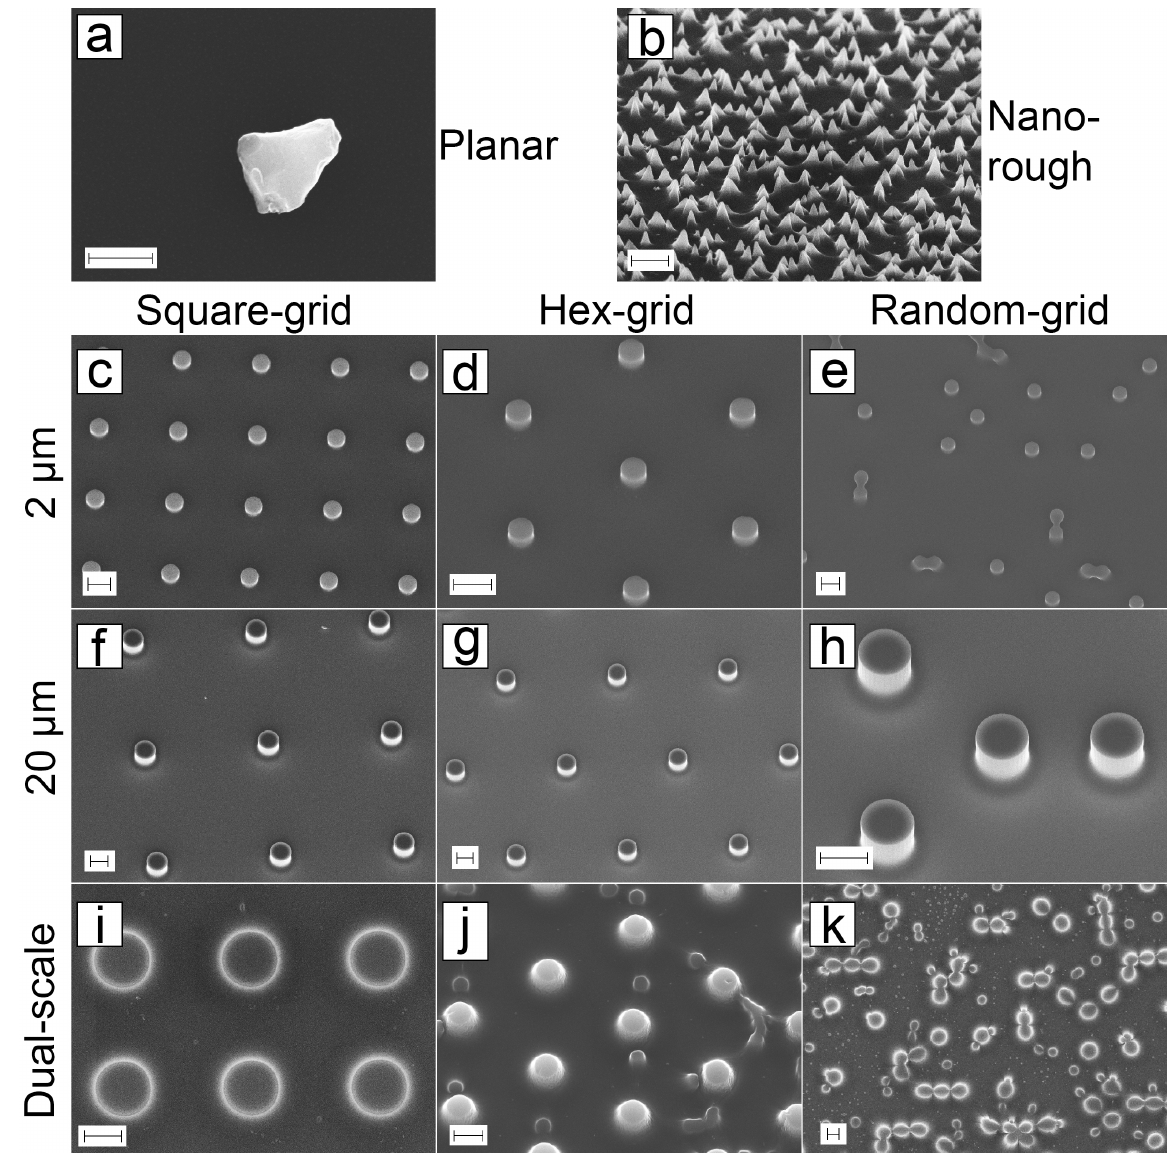
Figure 6. SEM images of PyC structures made with direct lithography ( a ), ( c – h ) and UV-embossing ( b ), ( i – k ). ( a ) Planar reference sample with silicon particle on the surface to show the absence of structures (scalebar: 1 µ m). ( b ) PyC nanopillars made with embossing (scalebar: 2 µ m). All pillar structures with three layouts: ( c – e ) 2 µ m pillars (scalebar: 2 µ m), ( f – h ) 20 µ m pillars (scalebar: 10 µ m) and ( i – k ) Dual-scale pillars (scalebar: 2 µ